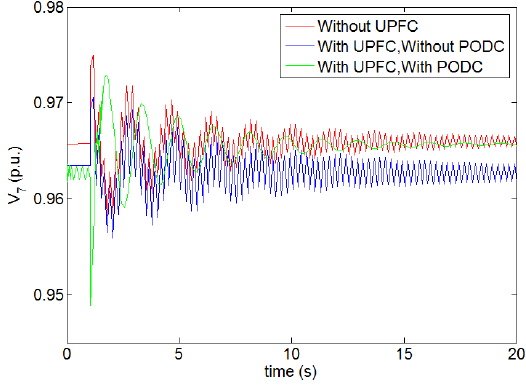
Figure 8. Response curves under different scenarios.